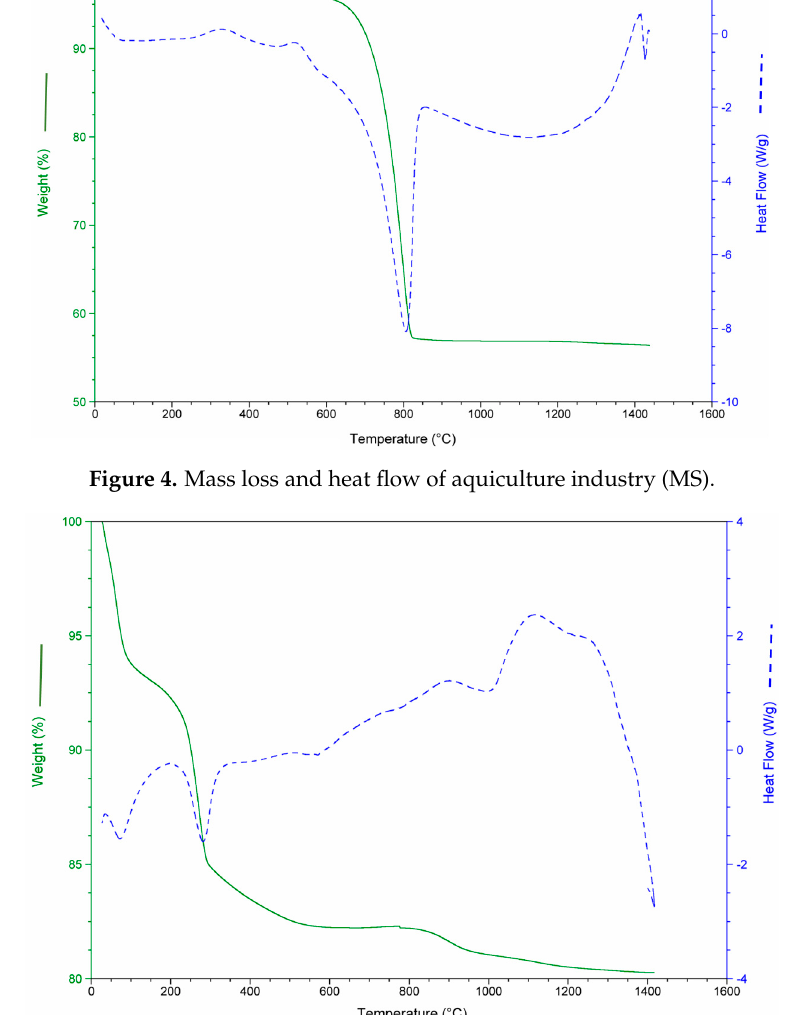
Figure 5. Mass loss and heat flow of aluminum recovery plant